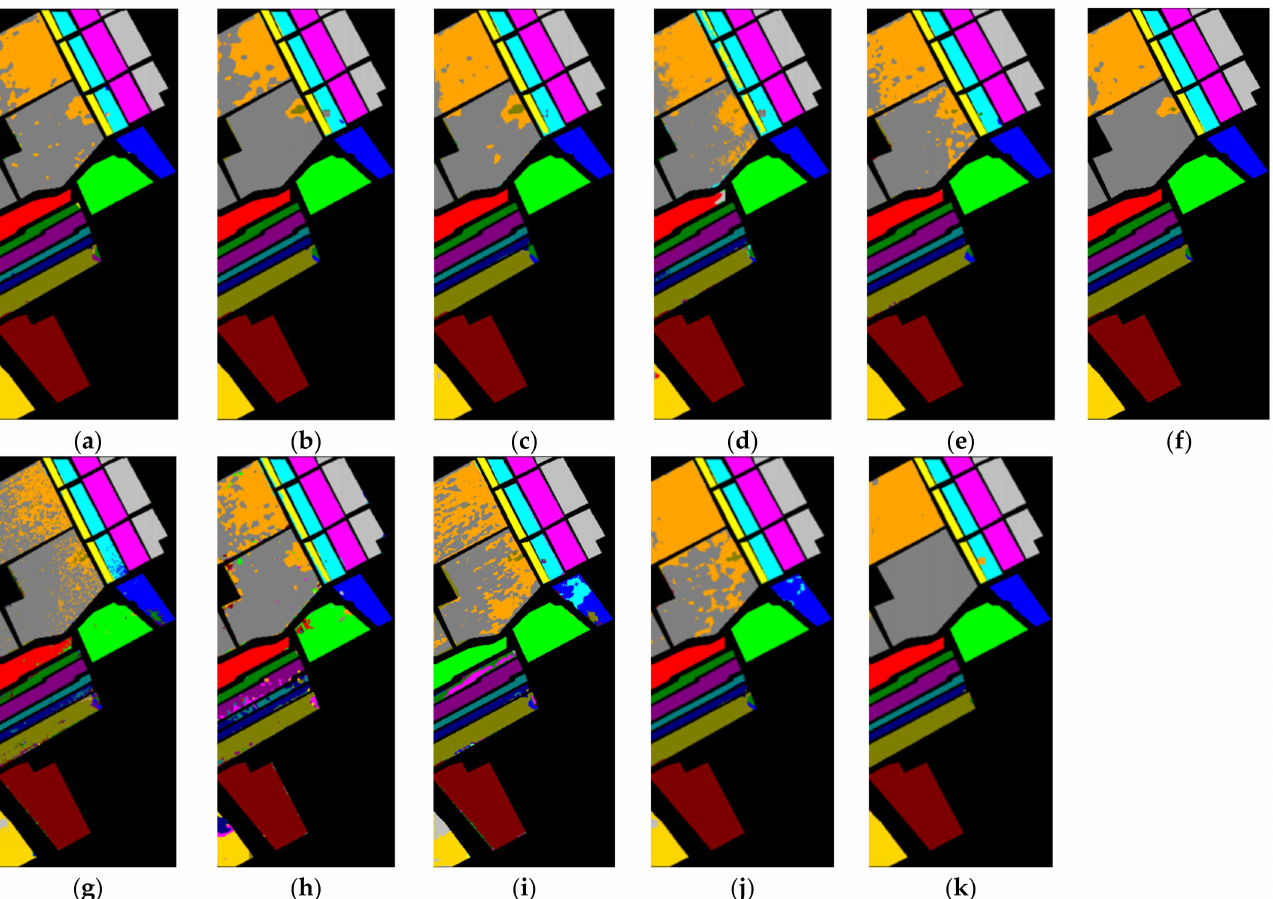
Figure 10. The overall accuracy and classification maps of different methods on SV dataset: ( a ) A2S2KResNe (94.58%); ( b ) DBDA (93.74%); ( c ) DBMA; ( d ) PyResNet (91.51%); ( e ) SSRN (92.04%); ( f ) ViT (95.79%); ( g ) SVM (86.98%); ( h ) HybridSN (87.33%); ( i ) CDCNN (88.36%); ( j ) FDSSC (95.79%); ( k ) proposed